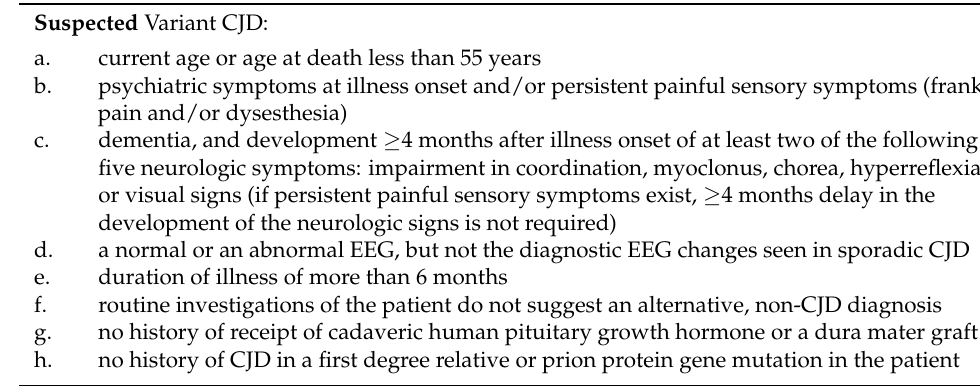
Table 3. Diagnostic criteria for suspected and definite